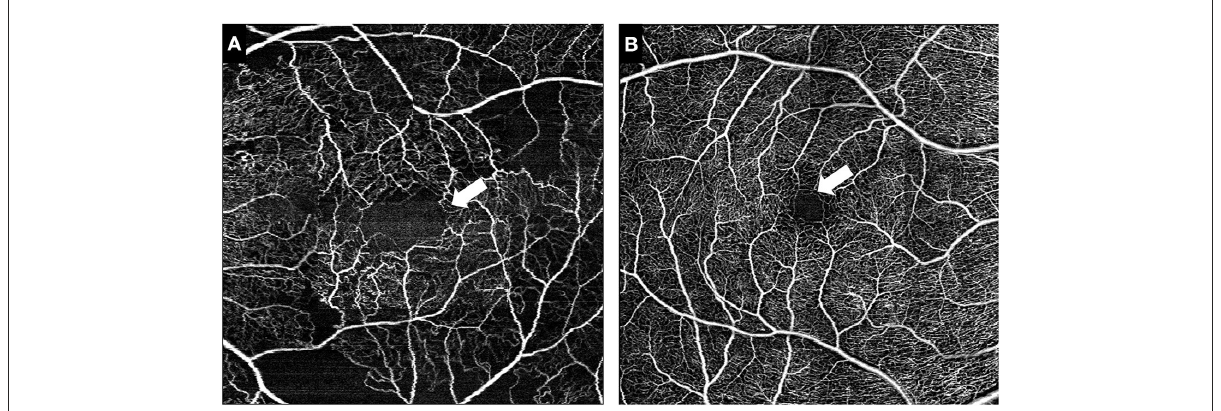
FIGURE1 Representative images of the foveal avascular zone (FAZ). White arrow indicates the outlines of the FAZ in a symptomatic RVCL-S patient (A) and an age-matched healthy control (B) .